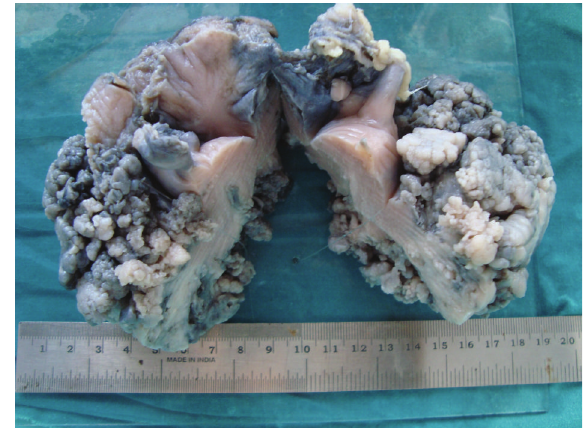
Figure 3: The cut section of the uterus showing large polypoidal mass arising from the cervix, which engulfs the anterior and poste- rior aspect of the uterus sparing the fundus and